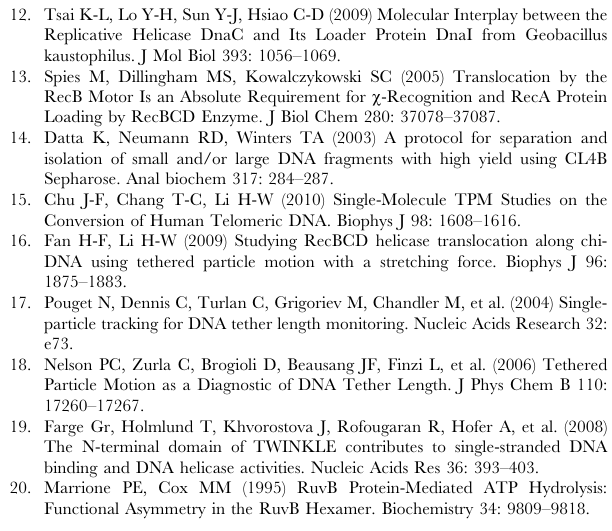
Figure S1 The rate of ATP hydrolysis of Gk DnaC WT in the presence of different length of ssDNA. Reactions were initiated by addition of Gk DnaC WT (1 m M), and the rate of ATP hydrolysis was monitored by following NADH oxidation at 340 nm. The experiments were performed using different length of ssDNA (15-mer, 30-mer and 70-mer). Except 70-mer ssDNA with random sequence, the ssDNA we used here all belong to single-stranded oligo-dT DNA (50 nM). Figure S2 The initial unwinding time point determina- tion by 1 st derivative. A–D. The raw data of helicase unwinding fork-AC90 DNA substrates, in the present of Gk DnaC wild-type, Gk DnaC + Gk DnaG, Gk DnaC mutant R332A and R145K146A, respectively. There is a recording dead time of about 20 s due to solution exchange and stage restabilization for imaging (shaded area). E–H. The 1 st derivative of the unwinding trace returns the initial unwinding time point. The solid red line represents the mean of the derivatives (which suppose to be zero). The dashed lines show the 95% marginal bond of the derivatives. It shows that after 270 sec, the derivatives grow over the bonds which indicate that the slope of the raw trace leaves zero at the time, that we determine as initial unwinding time point (red circle). Figure S3 Sequence alignment. The schematic diagram showed the sequence alignment of DnaB-like helicases from G. kaustophilus ( Gk DnaC), B. stearothermophilus ( Bst DnaB), Thermus aquaticus ( Taq DnaB), and E. coli ( Eco DnaB) that labeled with residue numbers relative to that of Gk DnaC. Residues that are completely conserved, identical and similar among family members are shaded in green, yellow and cyan, respectively. The asterisk showed the important residues (R45, R117, R120, R145, K146, K309, R330, R332, R344 and R420) that influenced DNA-bound. Figure S4 Gel shift assay of increasing concentrations of Gk DnaC WT. The DNA unwinding activities of protein were measured by monitoring the amount of unwound ssDNA product. The reaction was carried out in the presence of increasing